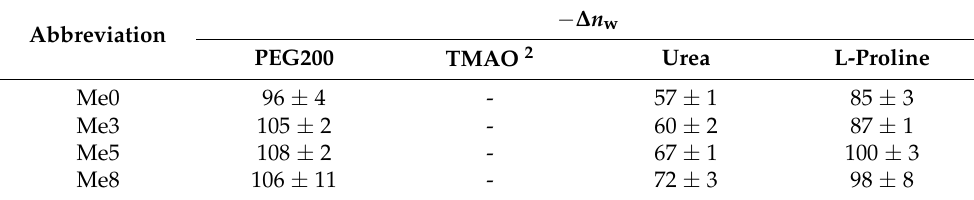
Table 2. The value of − ∆ n w for Me0, Me3, Me5, and Me8 in the buffer containing 100 mM